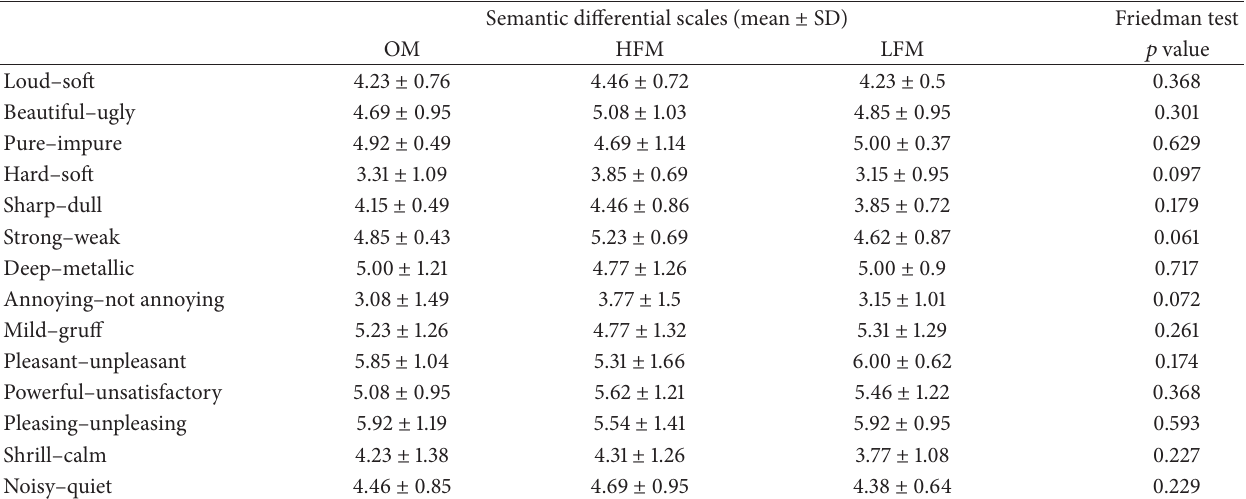
Table 2: Semantic differential